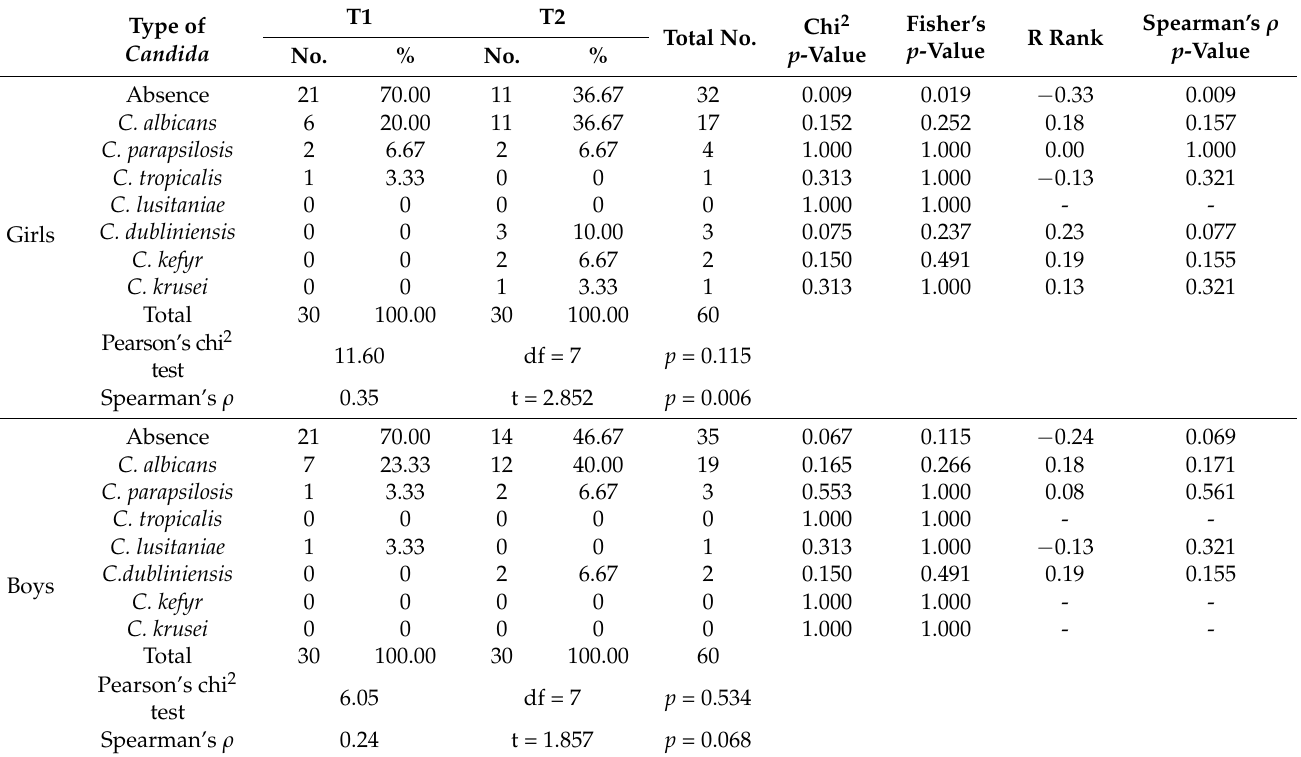
Table 4. The results of the prevalence of specific fungal species according to the time at which the study was conducted and the gender of the